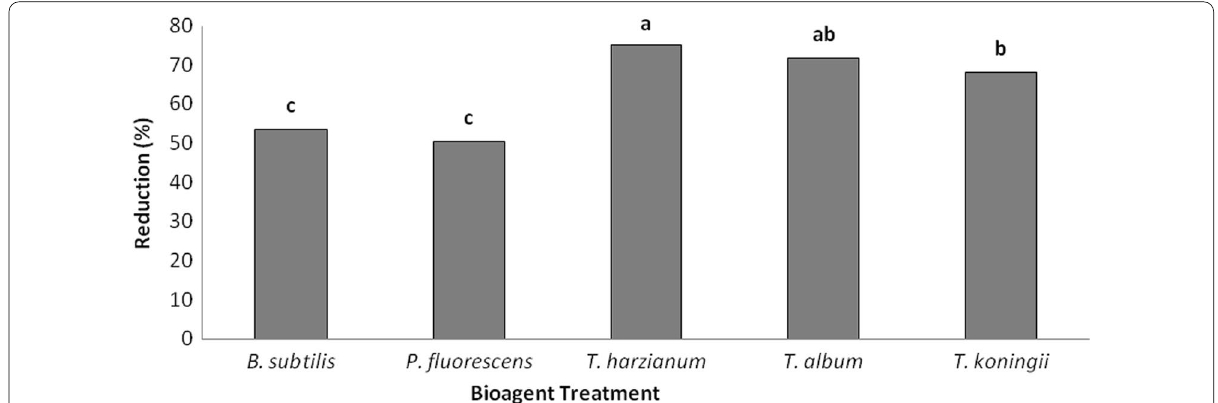
Fig. 1 Effect of PGPRs on mycelial growth reduction of Fusarium solani . Bars with different letters are significantly different (LSD, P >